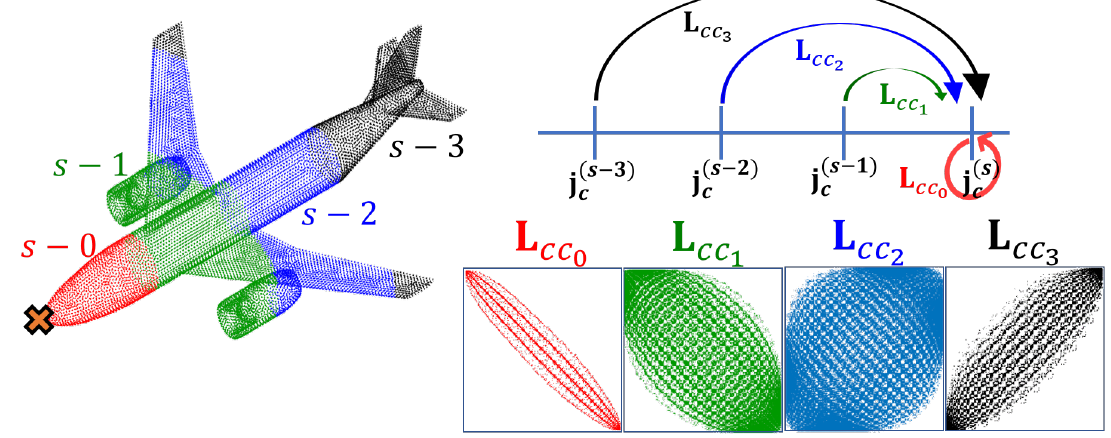
Figure 1. Marching matrices interactions